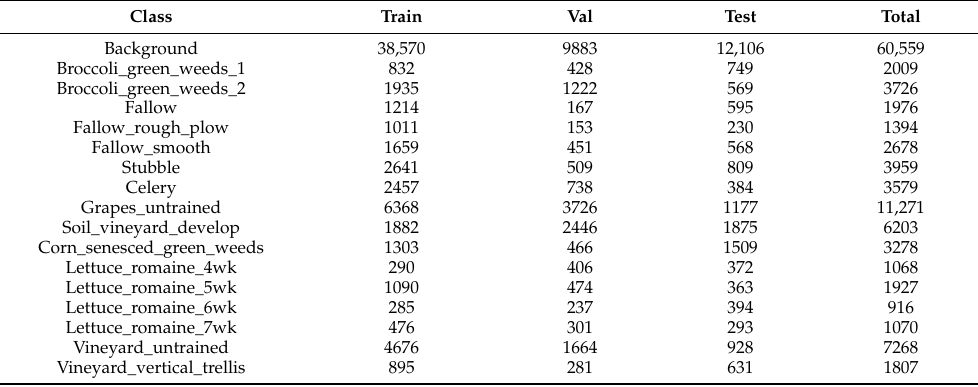
Table 1. Sample size of each class in each set after partitioning the Salinas